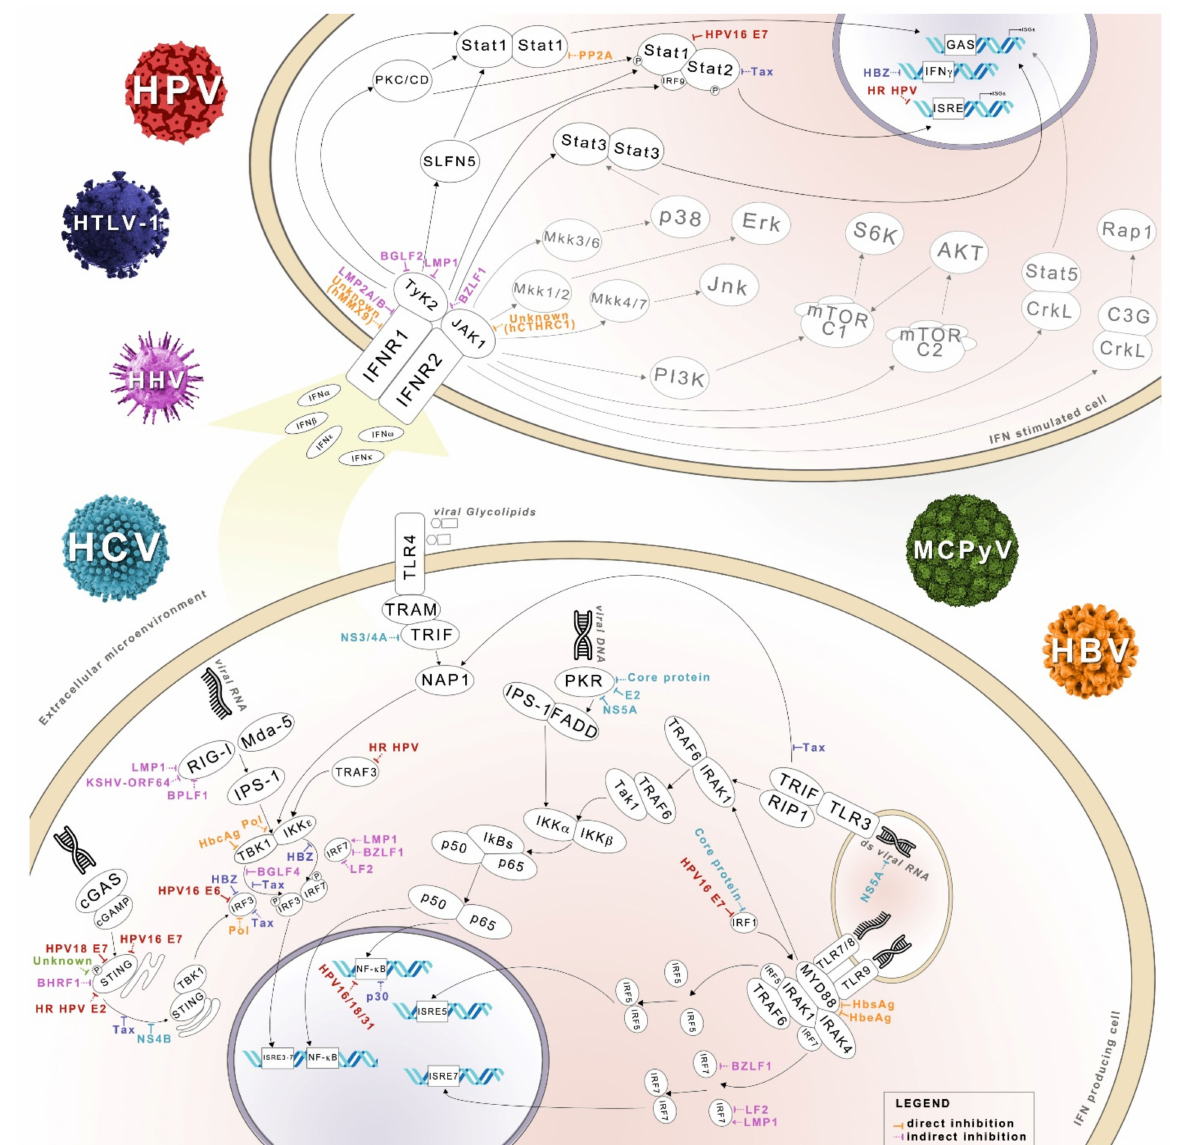
Figure 1. Signal transduction pathway network relevant for type I IFNs production and response to IFNs stimulus. Summary of the interfering oncoviruses proteins of different colors label is reported: HPV proteins (red), HTLV-1 (purple), HHV (pink), HCV (light blue), MCPyV (green), and HBV (orange). Faded pathways refer to non-canonical pathways involved in type I IFN signaling